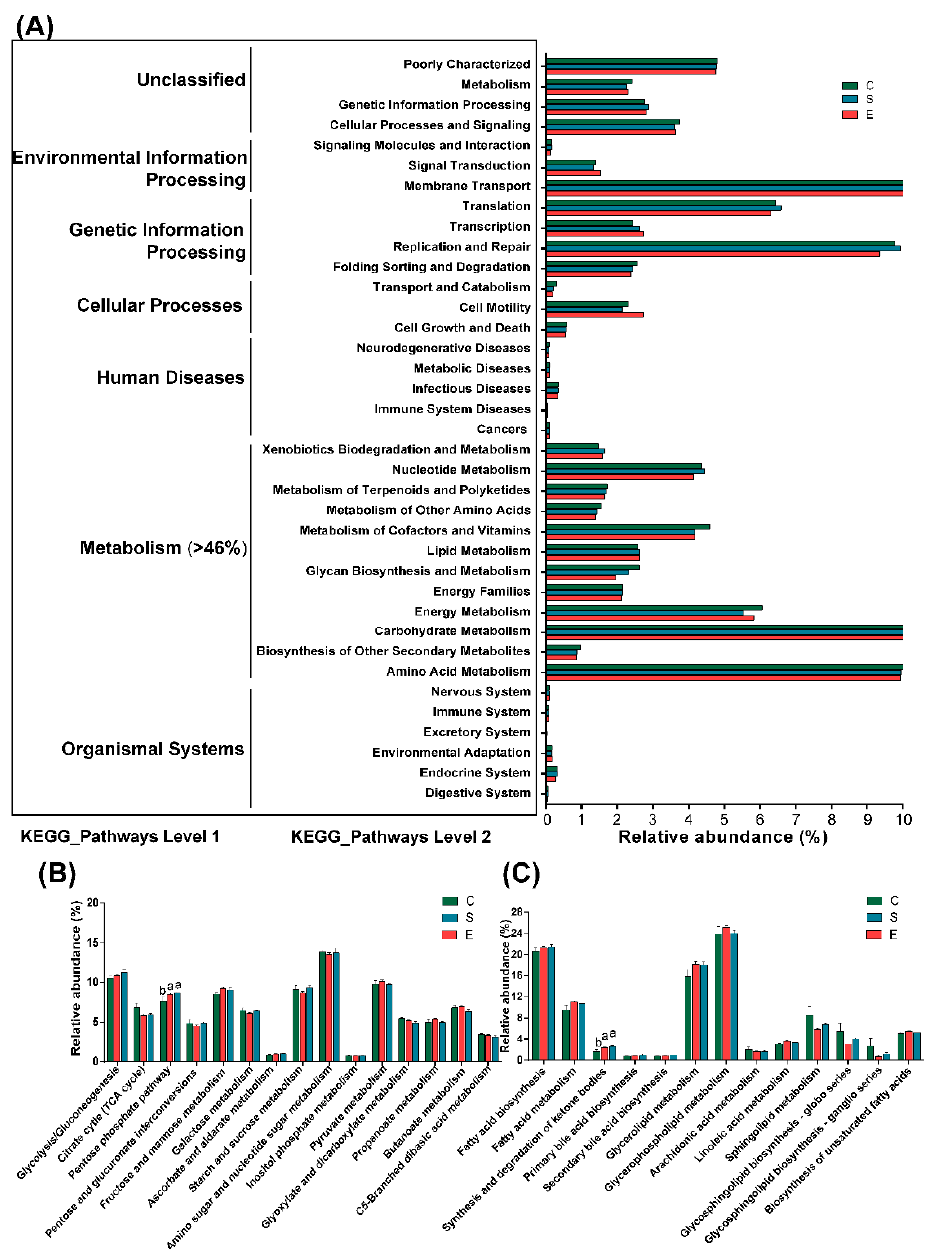
Figure 5. Differences of metabolism function profiles of bacterial community in goats fed different feed types of mulberry leaves used 16S data with PICRUSt. Relative abundance of the predicted different functional taxa at level 1 and 2 ( A ); relative abundance of carbohydrate metabolism ( B ) and lipid metabolism ( C ). The different lowercase letters in the bar chart indicate significant differences in the abundance of different pathways (the corrected p < 0.05).